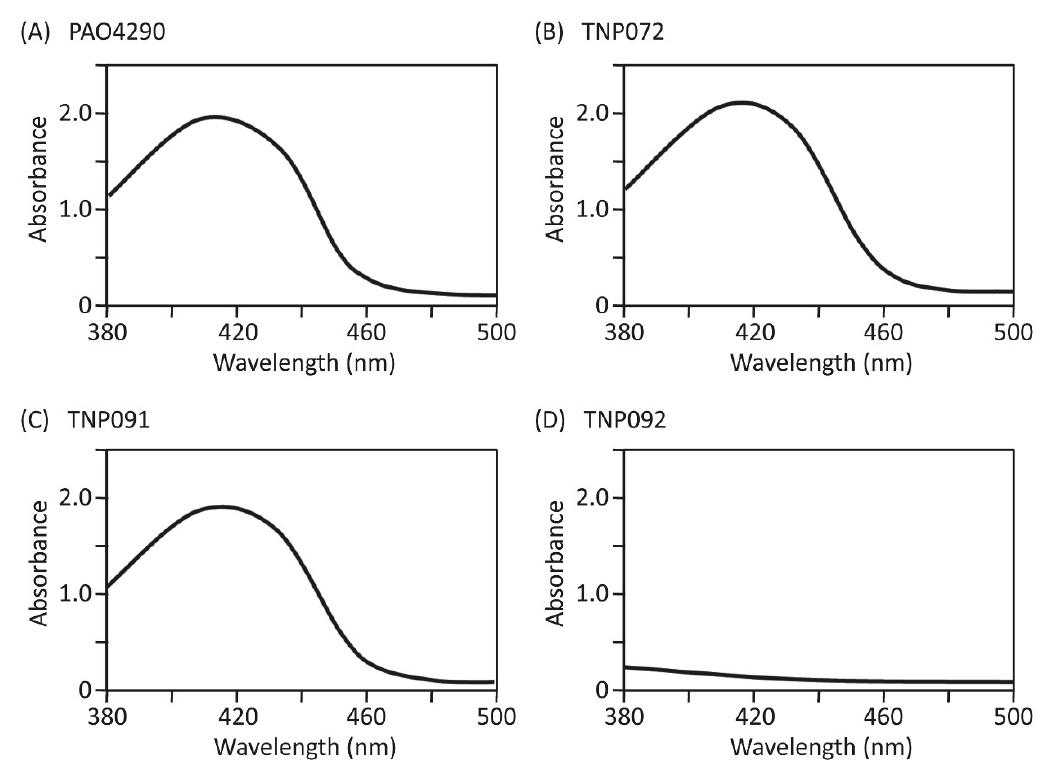
Figure 3. Absorption spectra of the culture supernatant. Cells were grown in casamino acid medium overnight at 37 °C under aerobic conditions and removed by the centrifugation at 13,700× g for 10 min. The clear supernatant fractions were scanned with a spectrophotometer. ( A ), PAO4290 (wild-type); ( B ), TNP072 ( Δ oprM ); ( C ), TNP091 ( Δ oprM , fpvA :: oprM ); ( D ), TNP092 ( Δ oprM , fpvA :: oprM , Δ pvdS